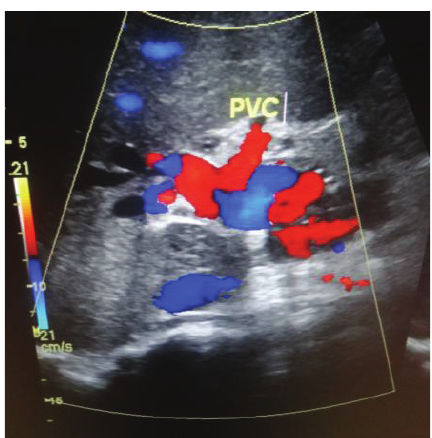
Figure 1: USG Doppler showing cavernous transformation of portal vein. PVC—portal vein cavernoma.